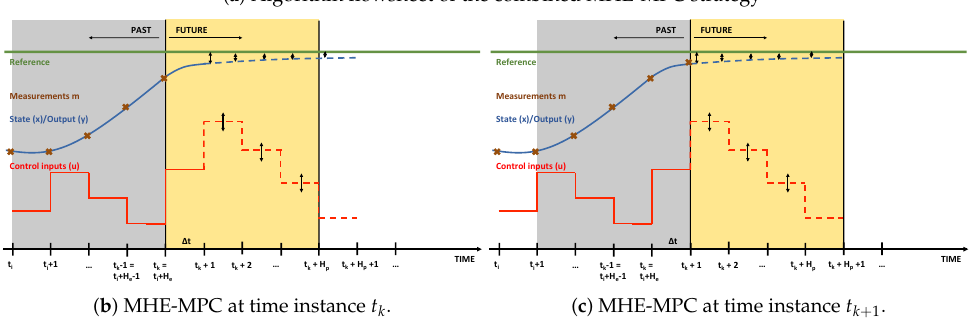
Figure 3. Overview of the combined MHE-MPC strategy: ( a ) algorithm, ( b ) combined MHE-MPC at t k , and ( c ) combined MHE-MPC at t k + 1